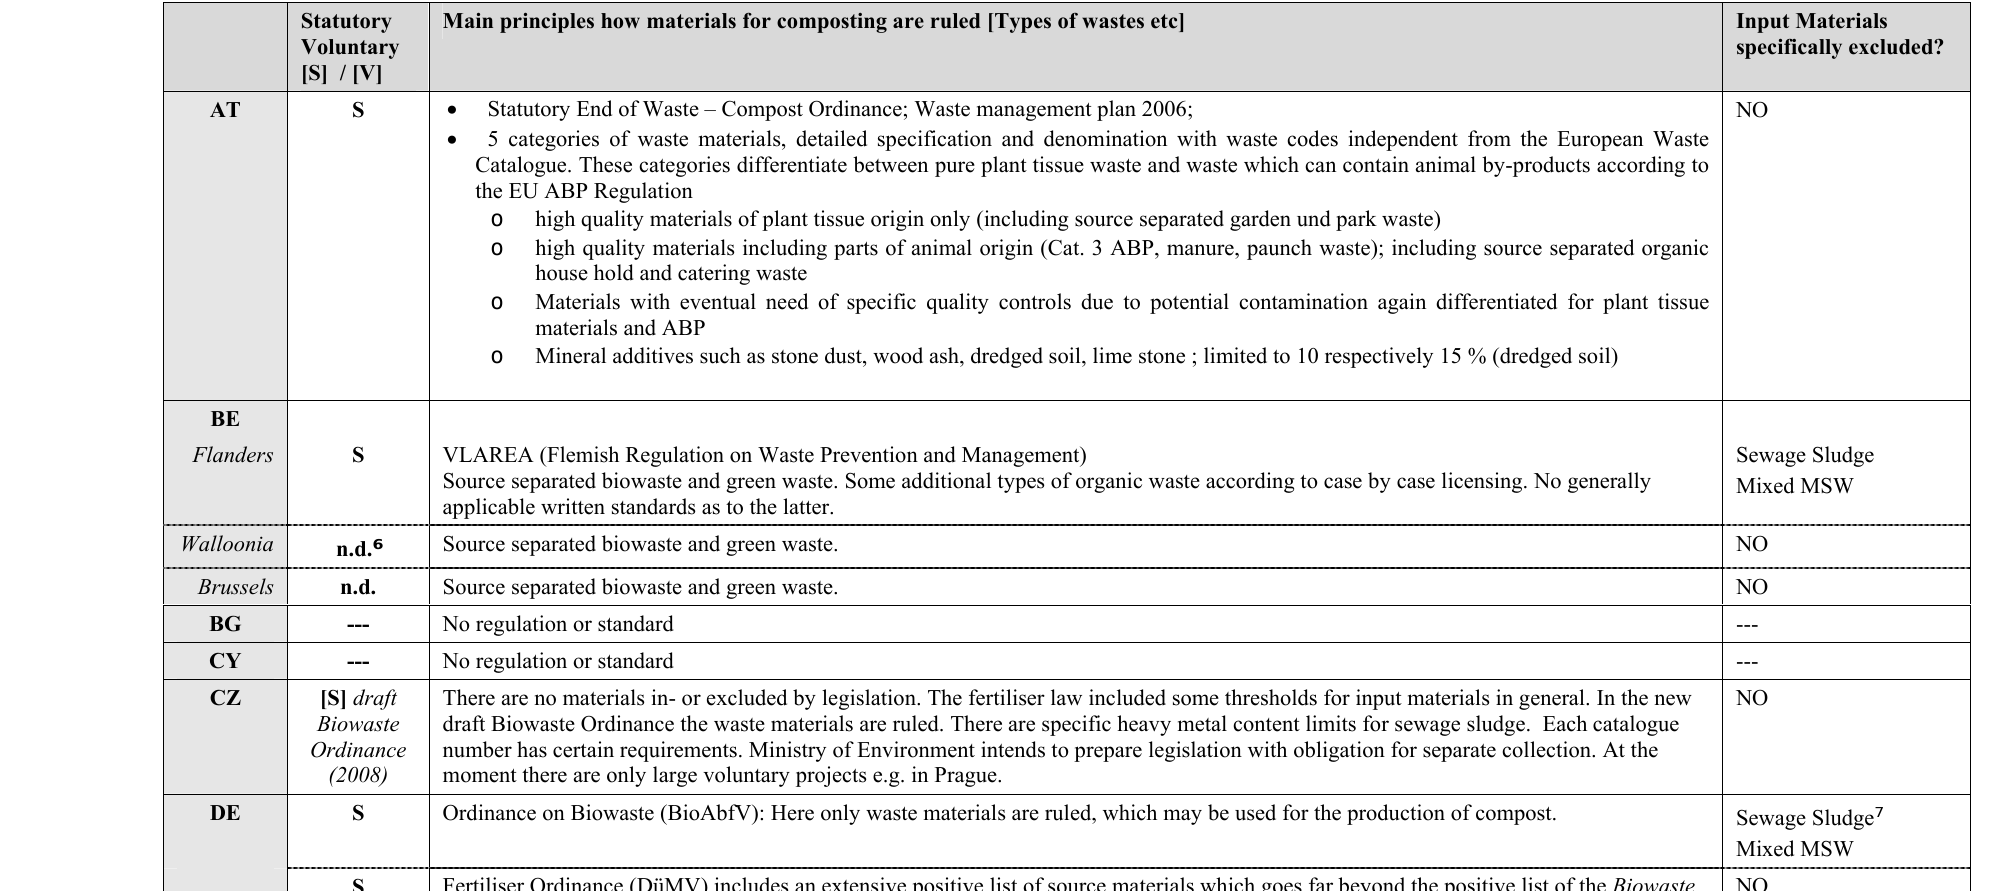
Table 4: General overview on the systematic of how Member States established specific requirements for input materials in